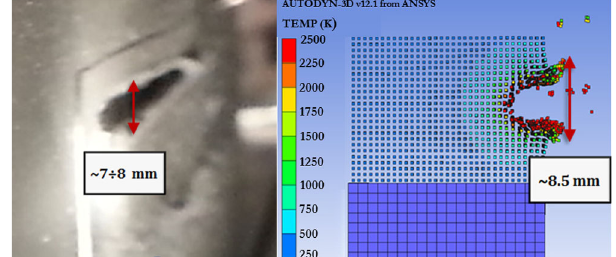
FIG. 26. Qualitative numerical benchmarking of the damage generated on the first Inermet 180 jaw block by Test 1 beam impact. Marked dimensions of the grooves extend to also take into account the plastically deformed zone in addition to the groove height.